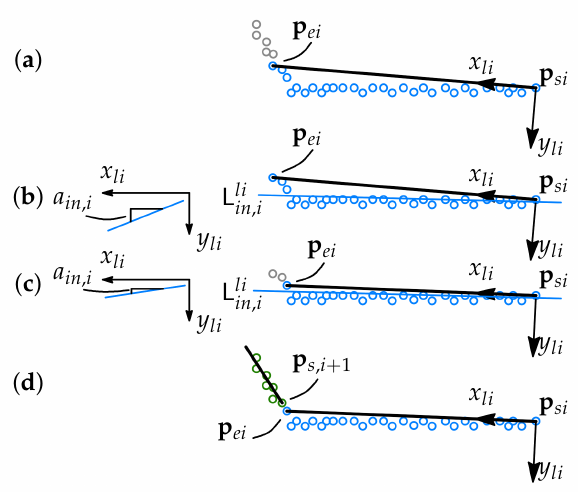
Figure 10. ( a ) Segment i and its local Frame li are defined over the inlier set, ( b ) A line fit L li the inliers is found and the a in , i coefficient of the line equation is evaluated, ( c ) several points are removed from the inlier set and a line fit is evaluated again, ( d ) when a in , i is within the tolerance, segment i is defined over the rest of the